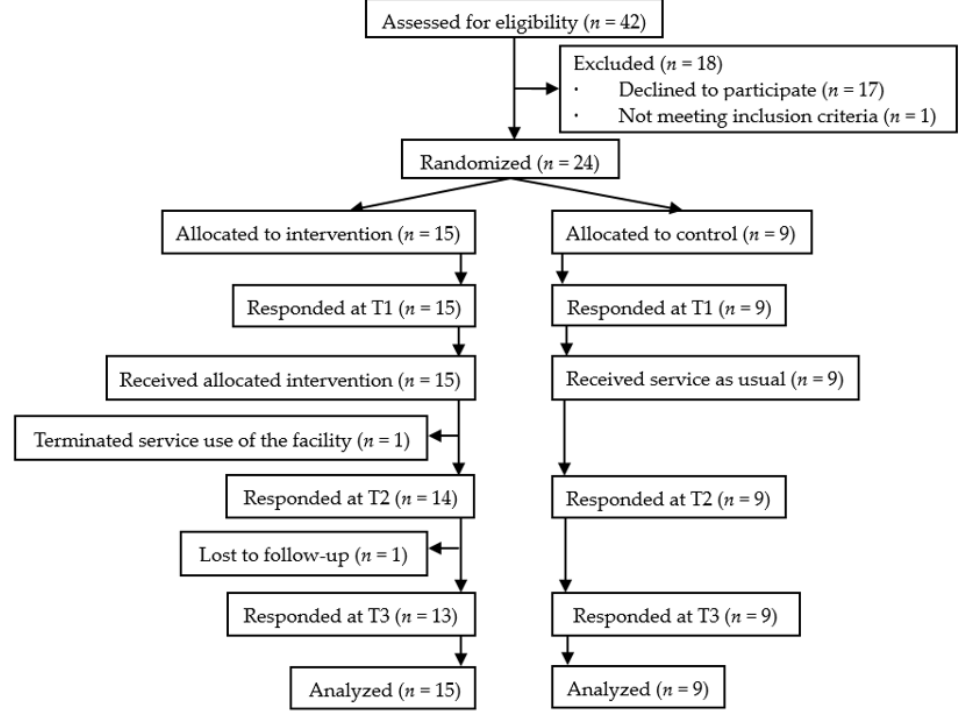
Figure 1. CONSORT flow diagram of the participants. T1: Baseline; T2: Post-intervention (eight weeks after baseline); T3: Three-month follow-up after the post-intervention.